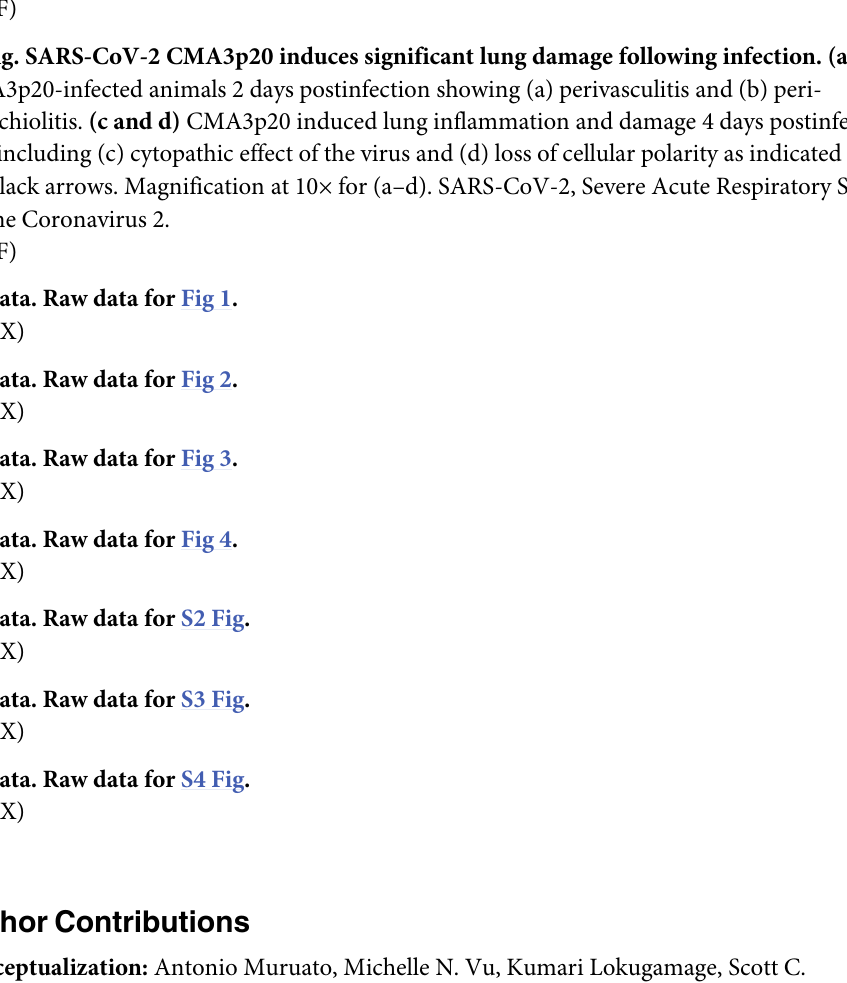
S1 Data. Raw data for Fig 1. S2 Data. Raw data for Fig 2. S3 Data. Raw data for Fig 3. S4 Data. Raw data for Fig 4. S5 Data. Raw data for S2 Fig. S6 Data. Raw data for S3 Fig. S7 Data. Raw data for S4